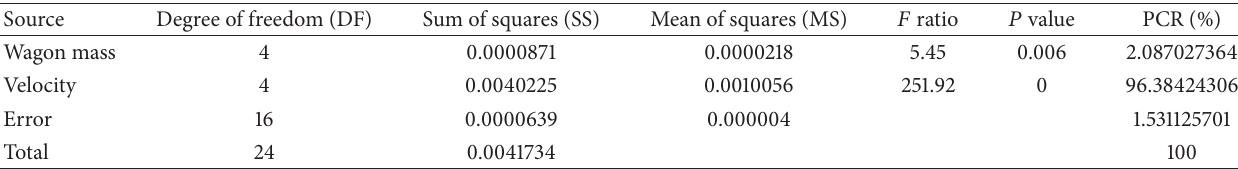
Table 6: Results of